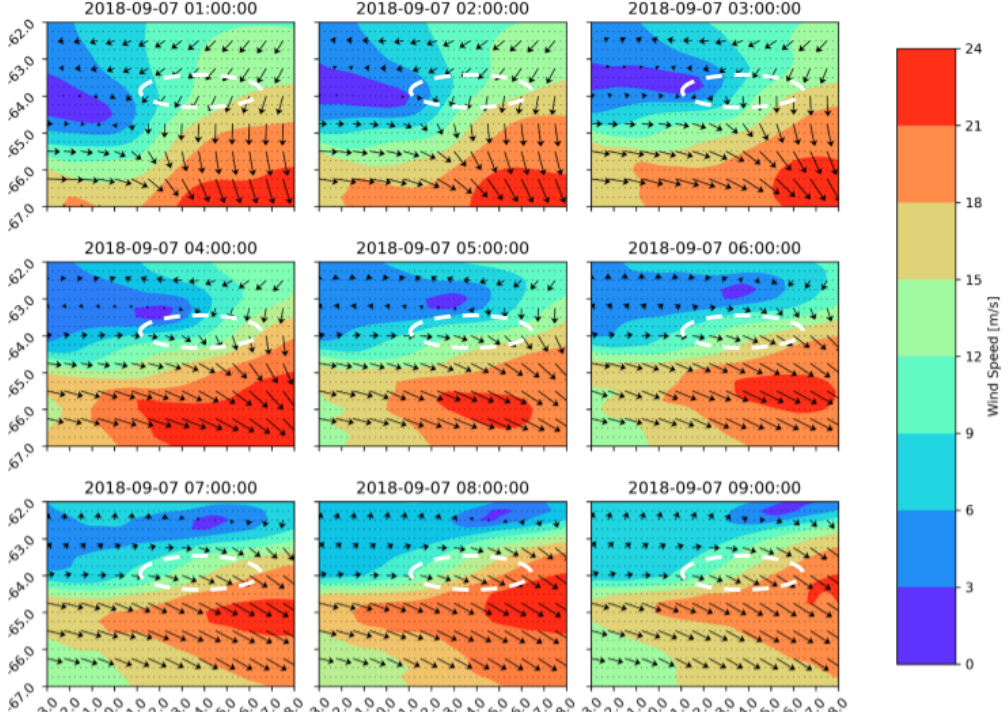
Figure 9. ERA5 quiver and contour plots of wind activity above Maud Rise for 9h on 7 September 2018, the day the 2018 sea ice anomaly starts to form. All times are reported as UTC. The sea ice anomaly extent (ASIT < 30cm) on 7 September 2018 is shown as a dashed white reference oval. All plots cover the area of interest outlined in Fig.